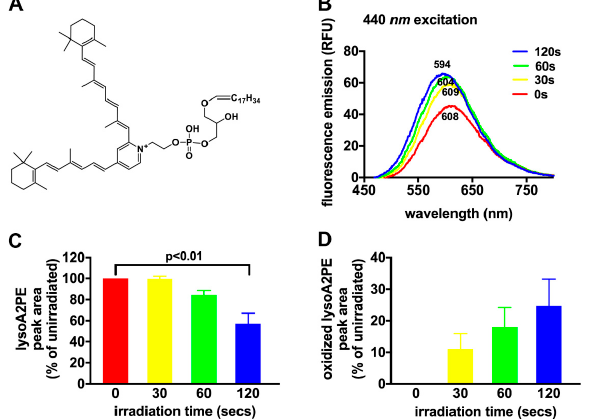
Figure 5. Photo-oxidation of alkenyl ether lysoA2PE (lysoA2phosphatidylethanolamine) (P-18:0/0:0) (P: plasmalogen, one cis double bond on the fatty acid chain). ( A ) The structure of lysoA2PE. ( B ) With excitation at 440 nm, lysoA2PE (in phosphate buffer with 2% DMSO (dimethylsulfoxide)) has an emission maximum at 608 nm. Fluorescence emission of lysoA2E when not irradiated (red trace) and when irradiated for the times indicated (yellow, green, and blue traces). Emission peak wavelengths are indicated adjacent to each trace. Note the increase in emission intensity and the peak shift to shorter wavelengths with increasing duration of irradiation. ( C ) Photo-oxidative loss of lysoA2PE is plotted as normalized peak area and as a function of irradiation time. ( D ) Formation of oxidized lysoA2PE is presented as normalized peak area and as a function of irradiation time.